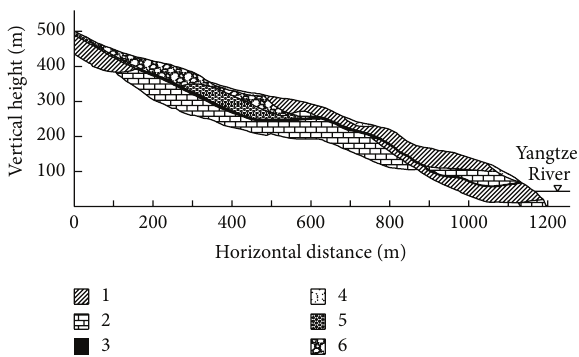
Figure 5: Simplified geological section map of Zhaoshuling Land- slide (plotted based on data of Comprehensive Investigation Insti- tute, China, Changjiang Water Resources Commission (1995)). (1) Limestone and limestone containing mud; (2) mudstone, siltstone, and argillaceous siltstone; (3) soft stratum; (4) landslide deposits; (5) red mud broken stone with soil; (6) gravelly